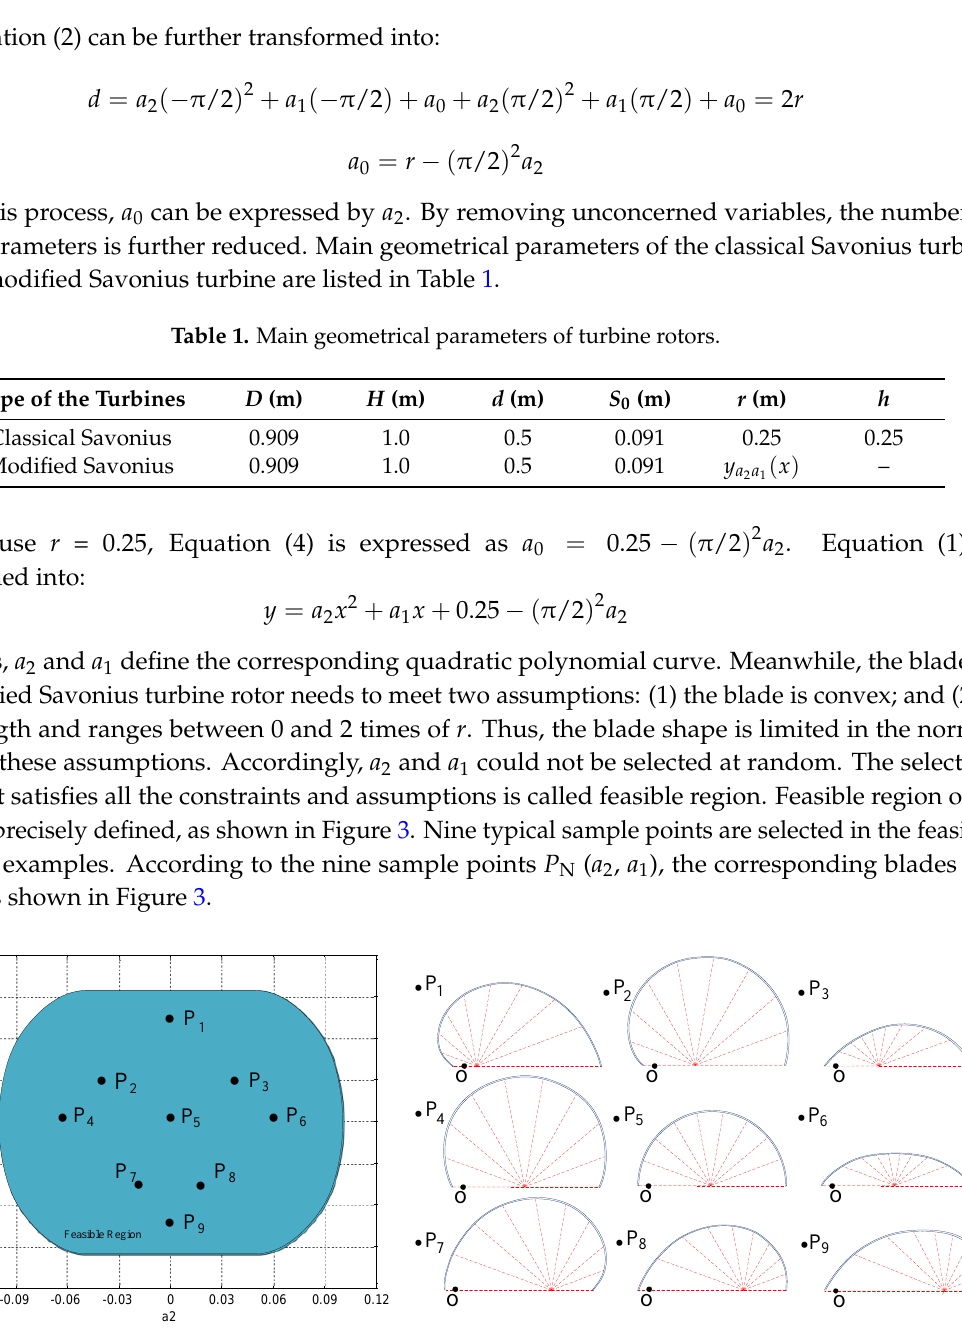
Figure 3. Feasible region ( a 2 and a 1 ), nine typical points and blades.